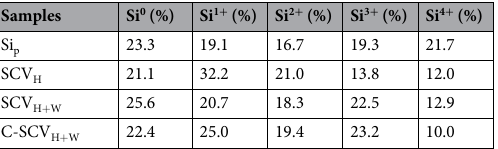
Table 1. Surface concentration measured by XPS deconvoluted by variety of oxidation states for Si2p spectra of Si P , SCV H , SCV H + W and C-SCV H + W